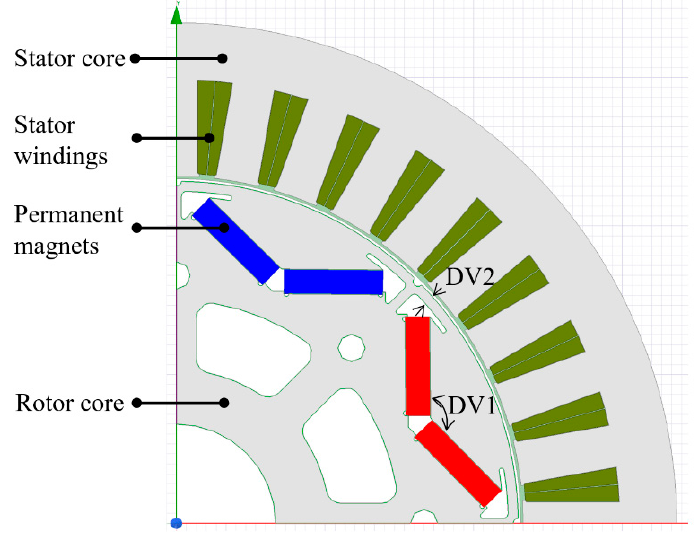
Figure 1. Flowchart of the overall research procedure.